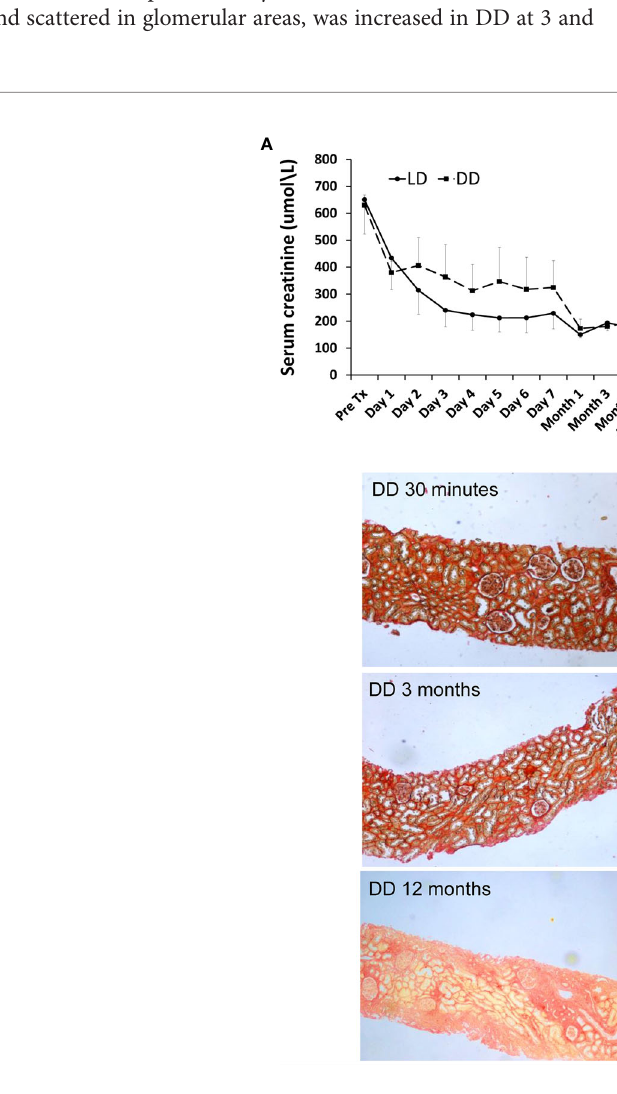
FIGURE 8 | Dynamic change of renal function and Sirius Red staining in 12 patients (6 LD and 6 DD) over a prolonged period up to 2-year post-transplant. (A) The data of SCr were collected at pre-transplantation, day1-7 daily, 1, 3, 6, 9, 12 and 24 months post-transplantation. (B) The change of Sirius Red staining at 30 minutes, 3 and 12 months. The staining was mainly located in tubulointerstitial areas, which was signi fi cantly increased at 3 and 12 months compared with 30 minutes in DD, without signi fi cant difference between time points in LD. *P < 0.05; **P <